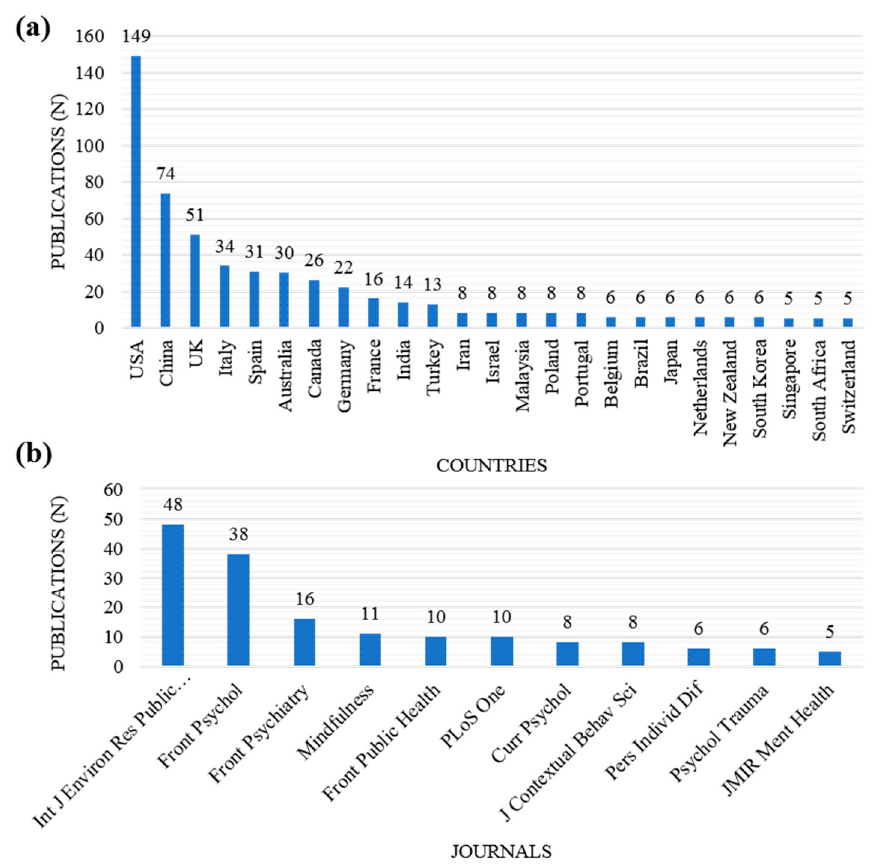
Figure 2. ( a ) Countries and ( b ) Journals with more than five articles published on mindfulness during the study period.